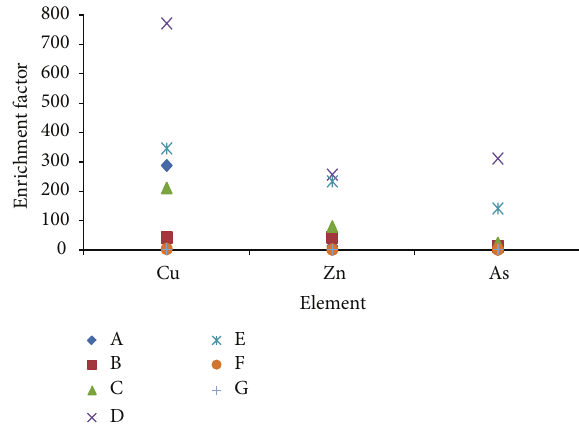
Figure 6: Spatial and temporal distribution of Sr.